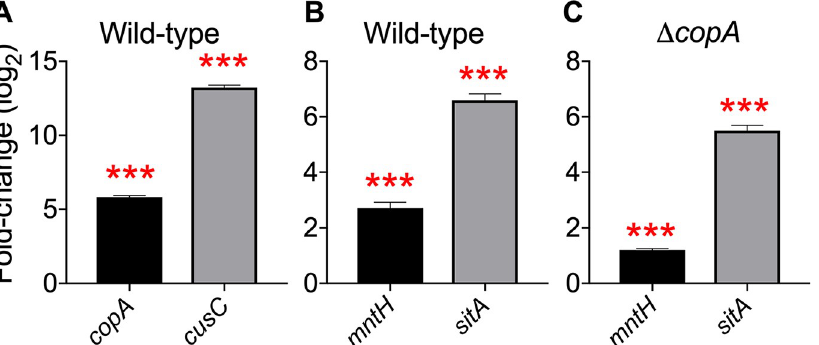
Fig 3. Copper induces the expression of copper efflux and manganese import genes. Wild-type UPEC strain CFT073 (A&B), or Δ copA mutant (C) was cultured in LB with or without copper to early logarithmic phase (OD 600 = 0.3). Real-time PCR was used to quantify copA (A), cusC (A), mntH (B&C), sitA (B&C) transcript levels. Relative expression, compared to no copper control, was calculated after normalizing to gapA transcript. Bars correspond to mean + SEM from 3 independent experiments. ��� P < 0 . 001 , t-